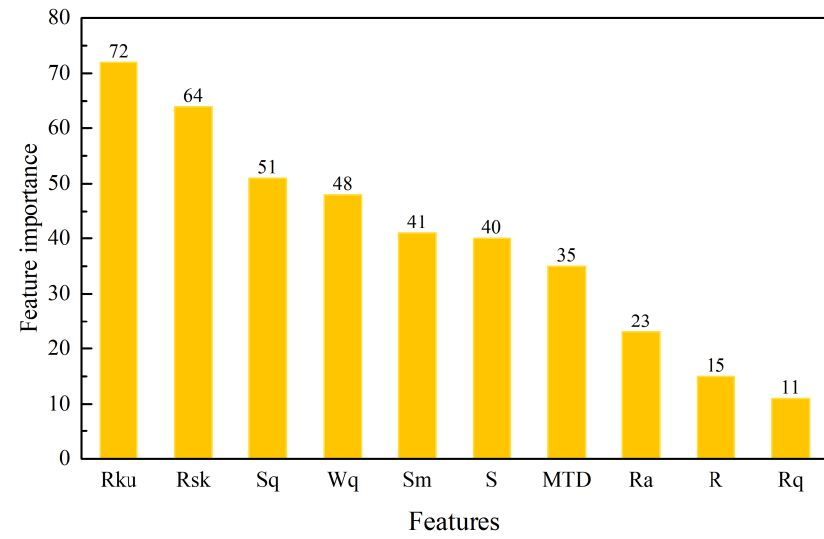
Figure 11. Feature importance analysis results.